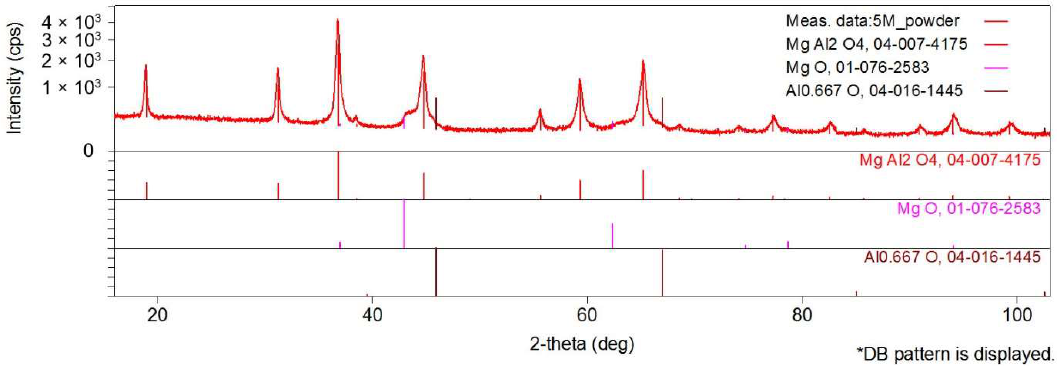
Figure A4. AZ63_20m sample—XRD qualitative phase analysis with displayed PDF cards peak bars.